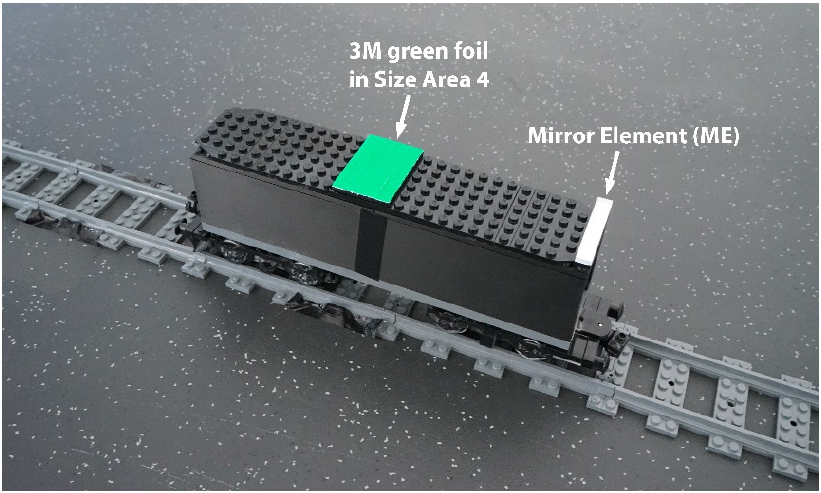
Figure 3. Lego train equipped with the mirror element and a 3M green foil of size Area 4.